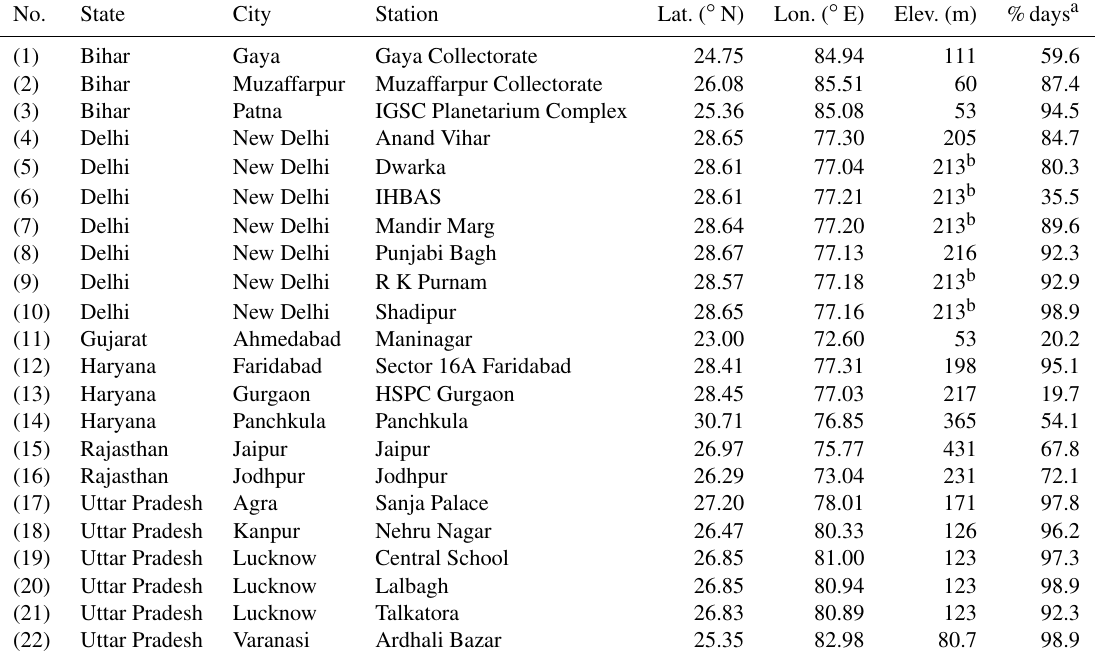
Table 1. Description of observation sites